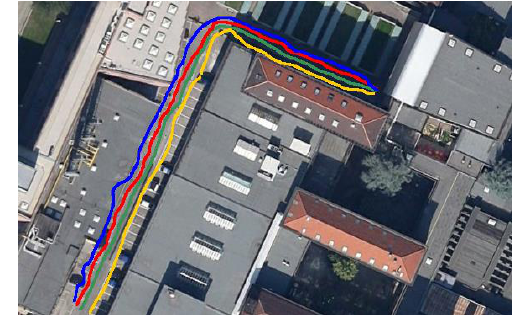
Figure 20 - Track results comparison The IBN solution obtained with IPHONE sensors (red line in Figure 20) brings to reach a horizontal error loop equal to 1.4 m and a vertical error loop equal to 0.26 m, considering a session length amount to 6 minutes. The error in the angular estimation is about 1.8 gons, estimating a noise equal to 0.4 gons. The IBN solution obtained with Samsung S4 sensors (blue